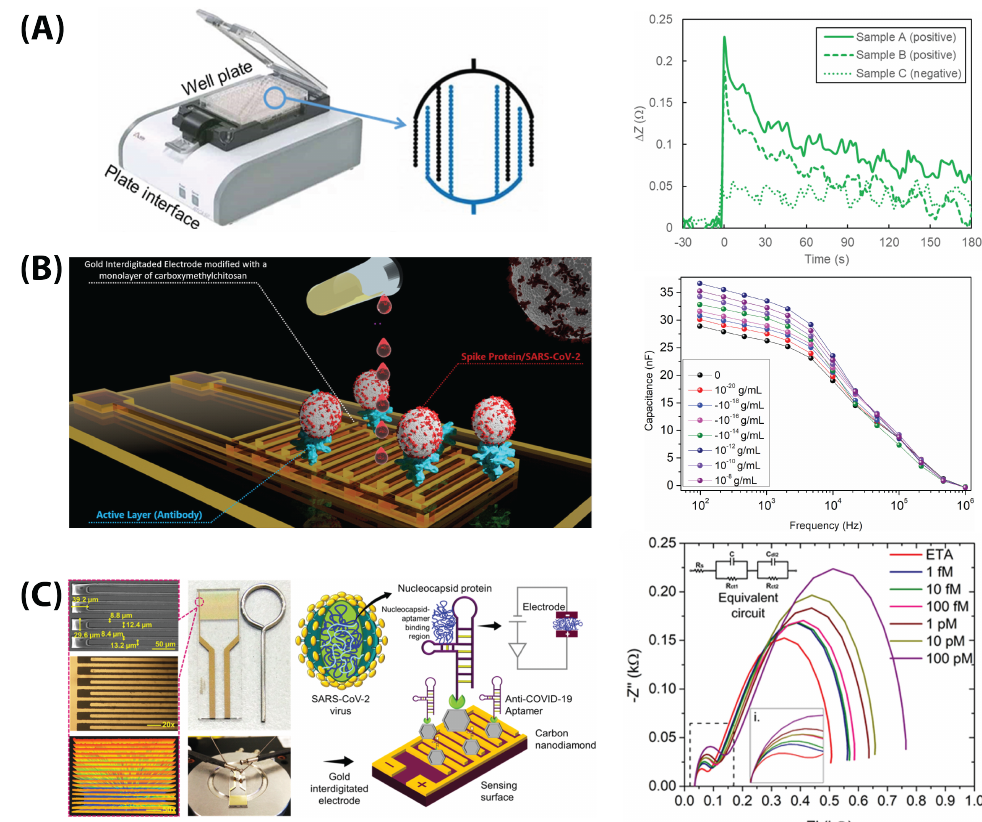
Figure 6. ( A ) Early on in the SARS-CoV-2 pandemic, Rashed et al.’s interdigitated electrode system was based on specialized plates and plate readers, and performed single-impedance readings